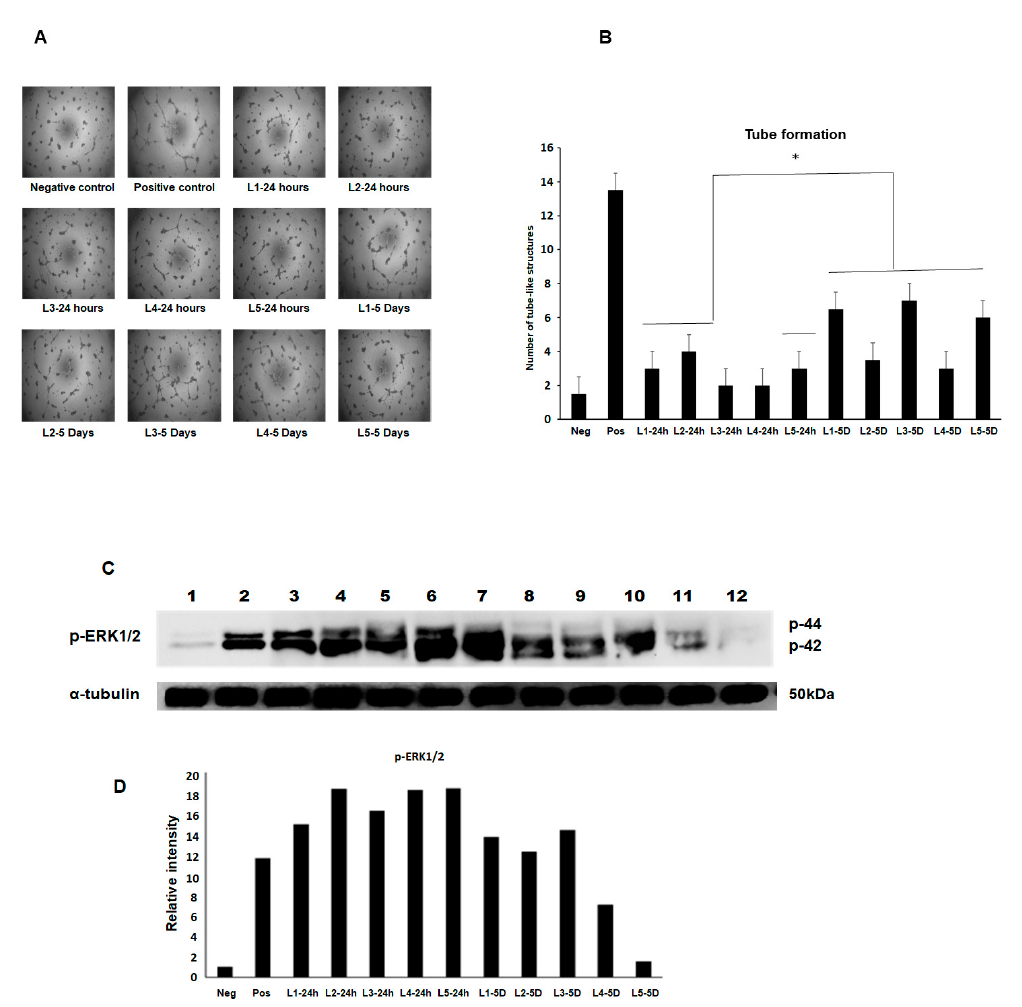
Figure 5. The pro-angiogenic effect of the MFAT serum free culture condition medium collected at day one and day five. The day five conditioned medium indicated a higher pro-angiogenic effect on the production of tube-like structures in BAEC than day one ( p < 0.05) ( A , B ). Western blotting in ( C , D ) shows the increased notable relative p-ERK expression in the conditioned medium of MFAT cultures after 24 h with a reduction in the day five conditioned medium. Lanes: (individual samples labelled as L) 1: Negative control (DEM, basal medium), 2: Positive control (EBM2, completed medium), 3: L1 24 h, 4: L2 24 h, 5: L3 24 h, 6: L4 24 h, 7: L5 24 h, 8: L1 five days, 9: L2 five days, 10: L3 five days, 11: L4 five days, 12: L5 five